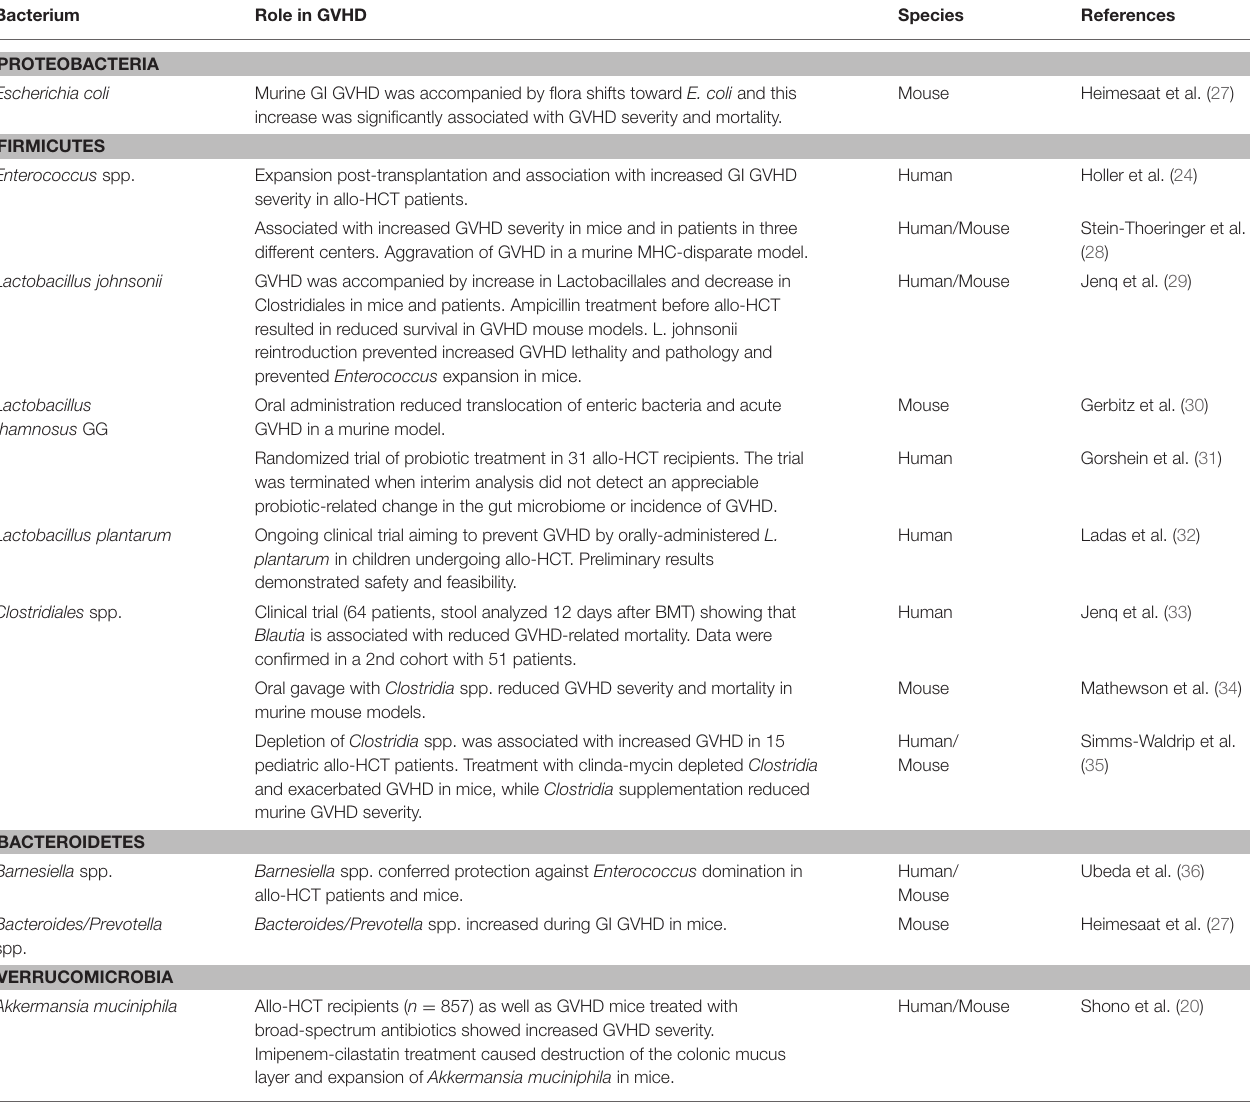
TABLE 1 | Summary of studies investigating how microbiota changes affect GVHD (structured by phylum).